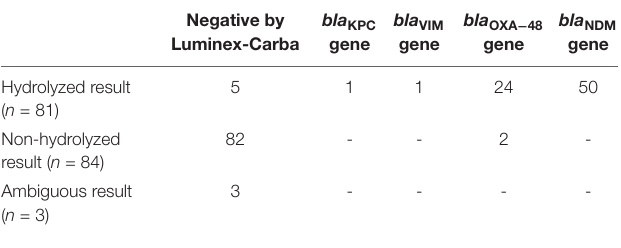
TABLE 2 | Correlation between MALDI-TOF assay and Luminex assay results.